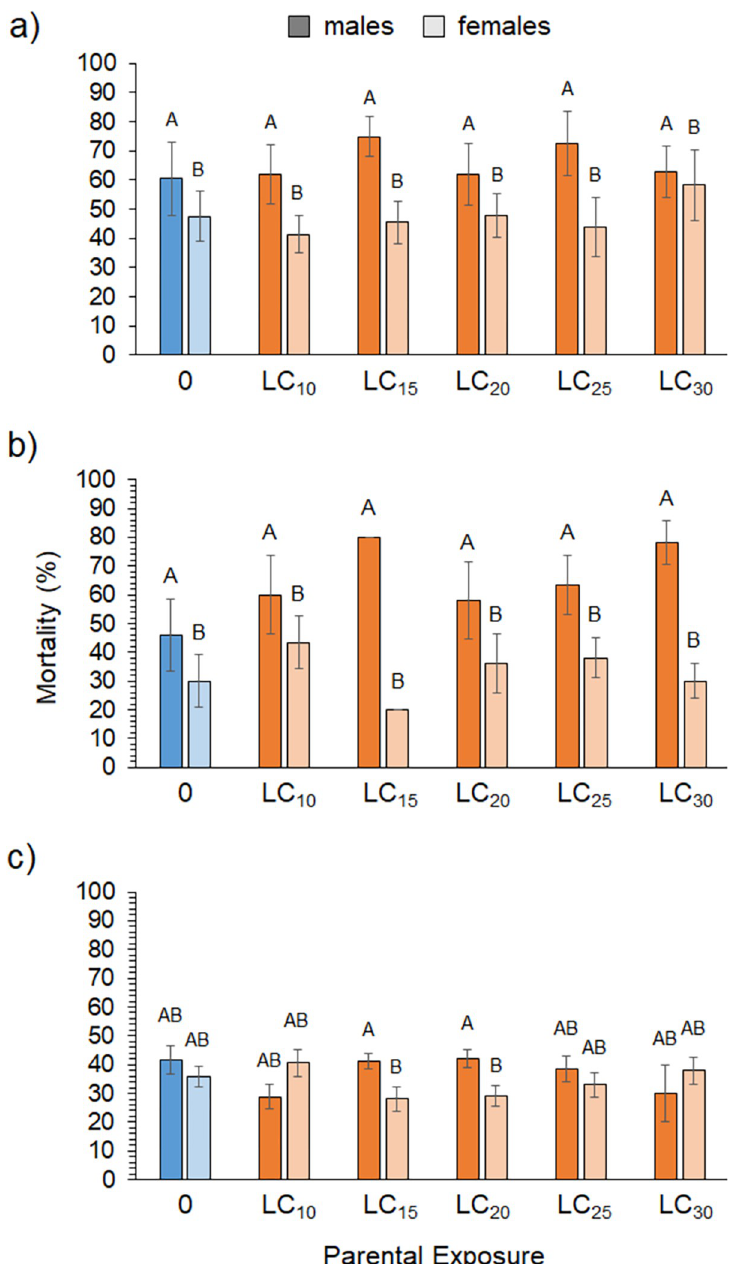
Fig 6. F1 Mortality. Average mortality of male (darker bars) and female (lighter bars) F1 flies from (a) zeta- cypermethrin (N = 6–10), (b) spinetoram (N = 1–10), and (c) pyrethrin (N = 6–10) parental exposure treatments after exposure to a diagnostic dose. Mortality of parental flies exposed to no insecticides are shown in blue, all other exposure concentrations are shown in orange. Different letters indicate significant post-hoc differences between the sexes for each treatment (Tukey’s Test, P �